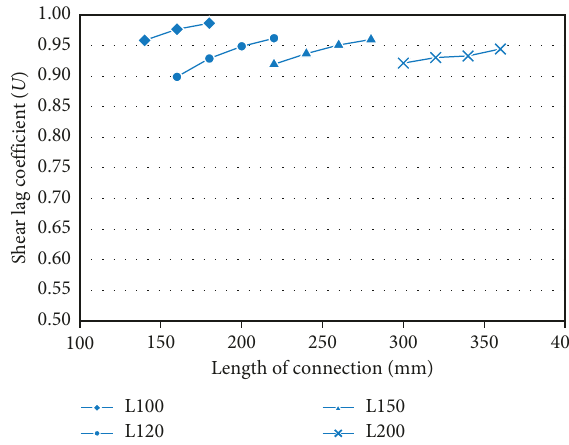
Figure 9: Effect of connection length on the tension capacity of double angles.